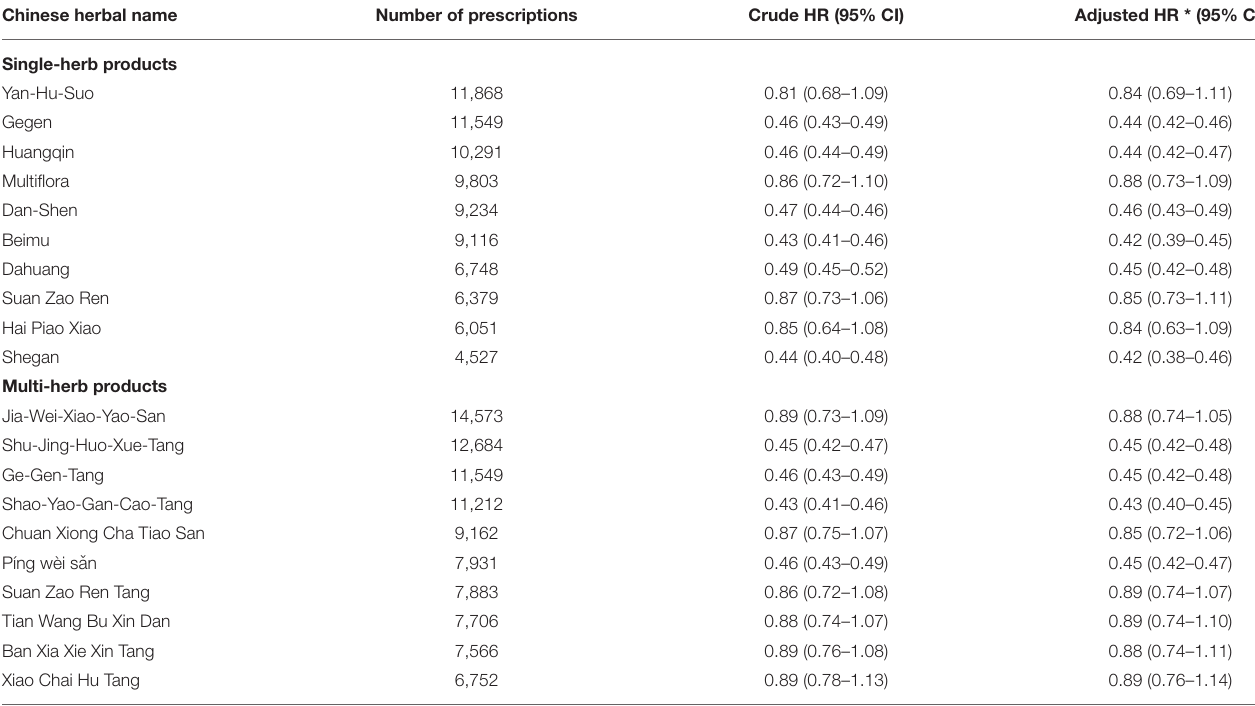
TABLE 4 | Risk of depression in relation to the 10 most-used single-herb and multi-herb products for insomnia patients. Chinese herbal name Number of prescriptions Single-herb